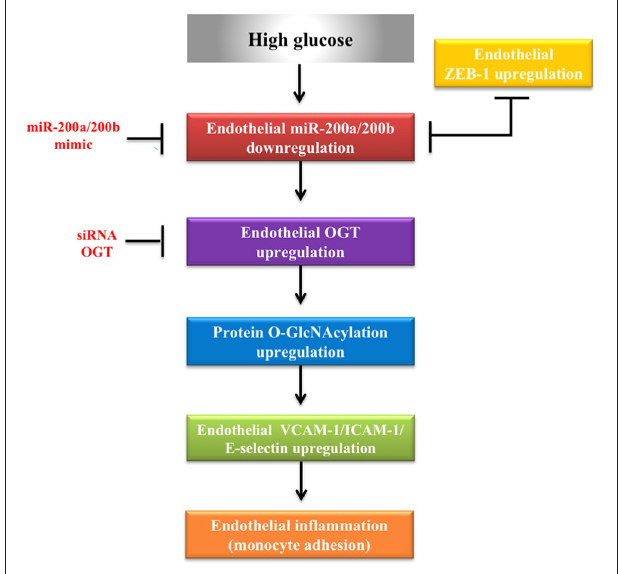
FIGURE 6 | Proposed role of miR-200a/200b in regulating HG-induced endothelial protein O -GlcNAcylation and inflammation via